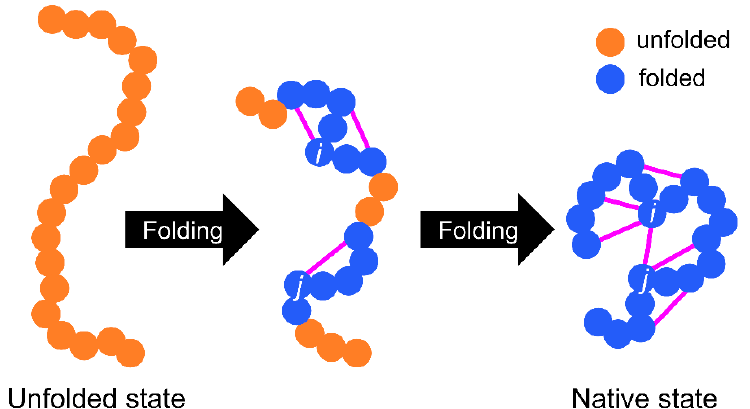
Figure 1. Schematic representation of a protein-folding process in the Wako–Saitô–Muñoz–Eaton (WSME) model. Residues in folded or unfolded conformations are indicated by blue and orange circles, respectively. Native contacts indicated by magenta lines are formed only when all intervening residues are cooperatively folded into the native-like conformations.